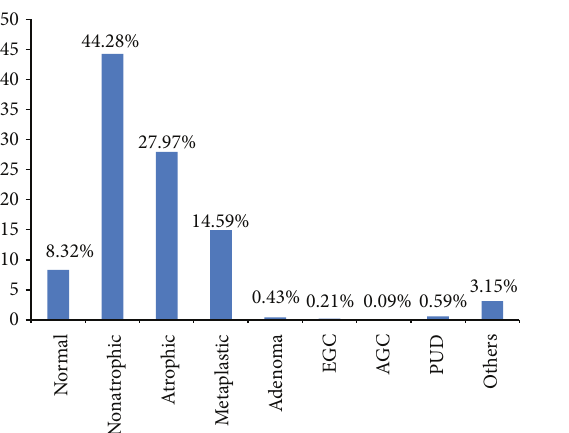
Figure 1: Overall prevalence of gastric diseases. EGC: early gastric cancer; AGC: advanced gastric cancer; PUD: peptic ulcer